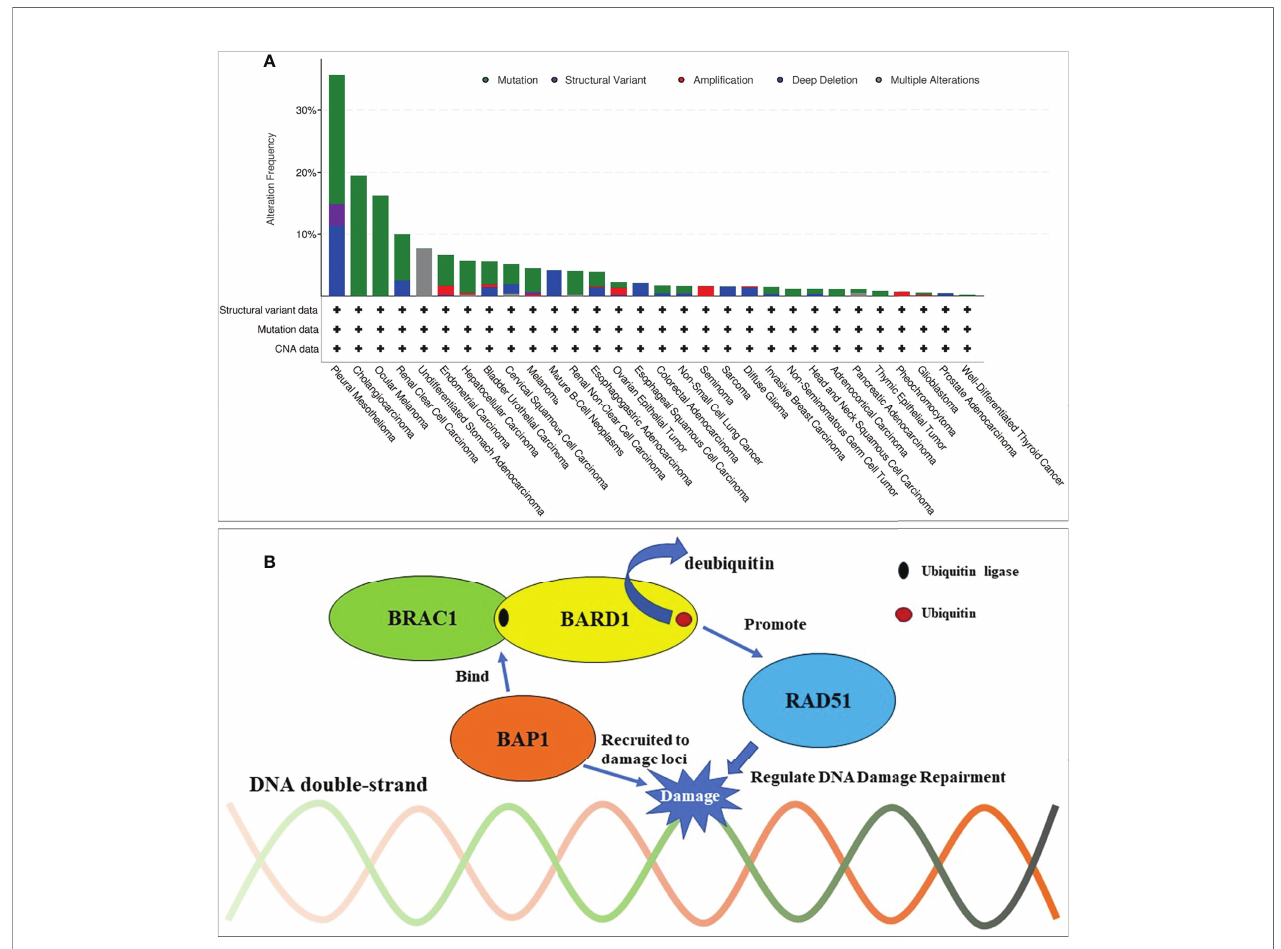
FIGURE 3 | Frequencies of BAP1 alteration across cancer types and mechanism of BAP1 in DNA damage repairment. (A) BAP mutations most commonly occurred in pleural mesotheliomas, cholangiocarcinoma, ocular melanoma, and renal clear cell carcinoma from a total of 32 large-scale TCGA PanCancer Atlas Studies that contained 10,967 samples. (B) Mechanism of BAP1 in DNA damage repairment. BRCA1/BARD1 complex is an E3 ubiquitin ligase and interacts with the recombinase RAD51 to regulate the homologous recombination repairment. BAP1 can be recruited to DNA damage loci and bind to the BRCA1/ BARD1 complex. By this, BAP1 can inhibit the E3 ligase activity of BRCA1/BARD1 to protect against additional ubiquitination and deubiquitinate preexisting ubiquitin chains (bent